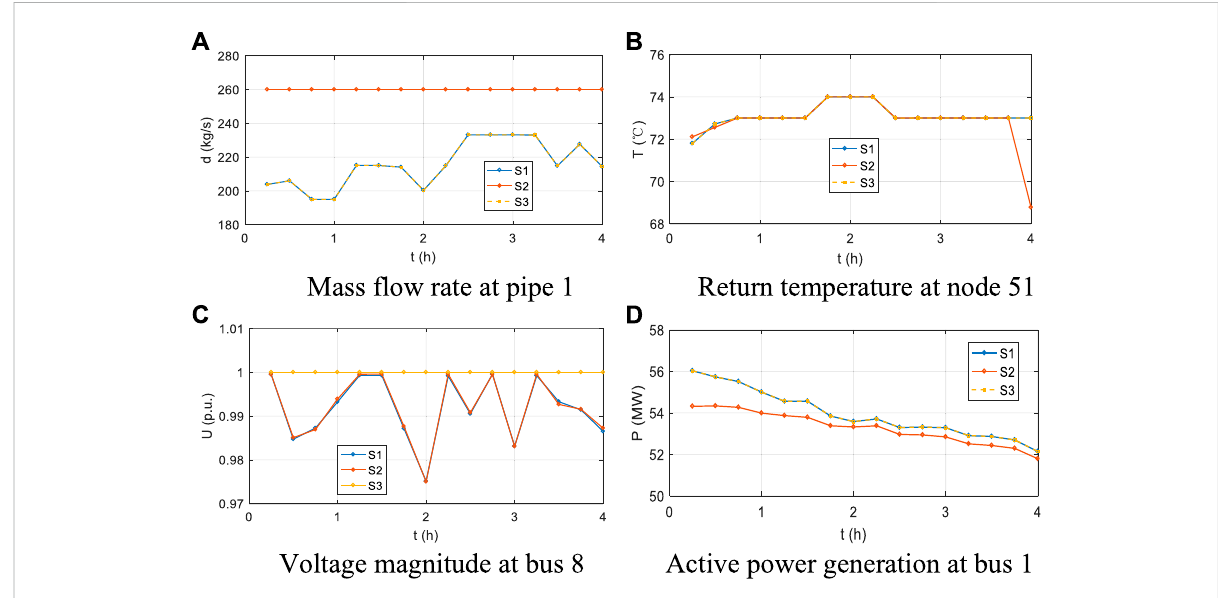
FIGURE 7 OEF results in three scenarios in Case